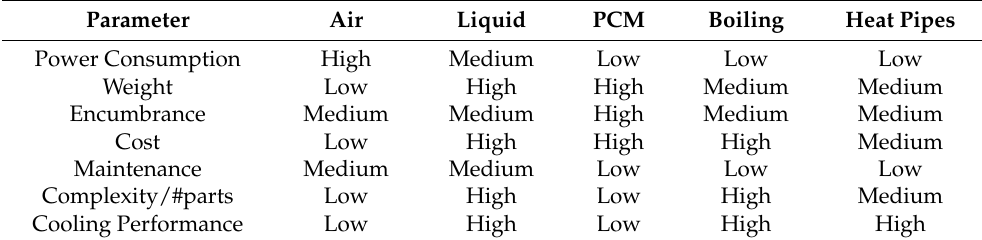
Table 1. Comparison of TMS solutions for EVs, over key parameters linked to the issues raised by the costumers in purchasing an EV